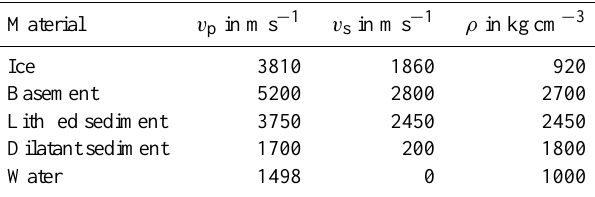
Table 3. P-wave velocity, S-wave velocity and density for different bed scenarios and isotropic ice as given in Peters et al. (2008). These values are used for the calculation of reflection coefficients given in Fig.